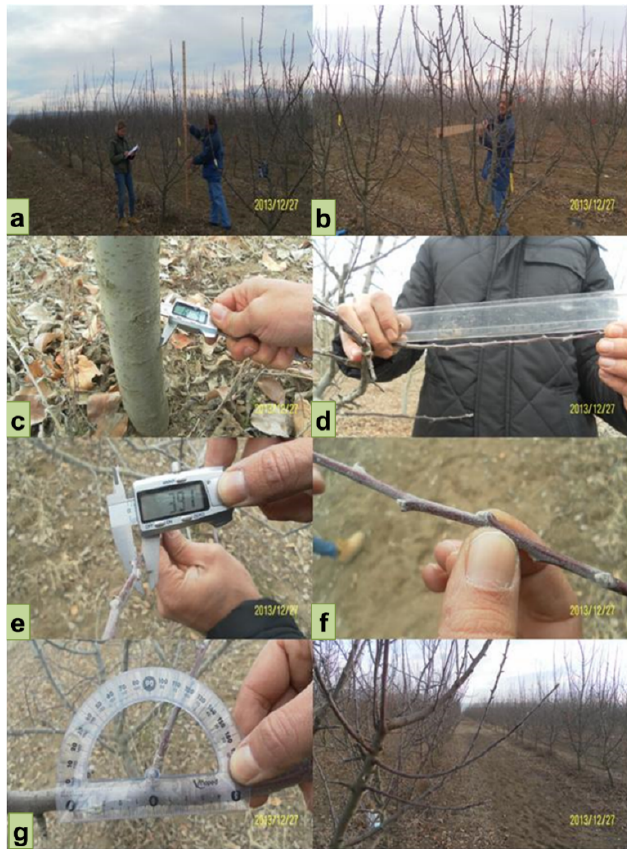
Fig. 2: Illustration of observations and measurements (a) Tree height, (b) Canopy width, (c) Trunk diameter, (d) Average shoot length, (e) Av- erage shoot width, (f) Average internode length on shoots, (g) Shoots crotch